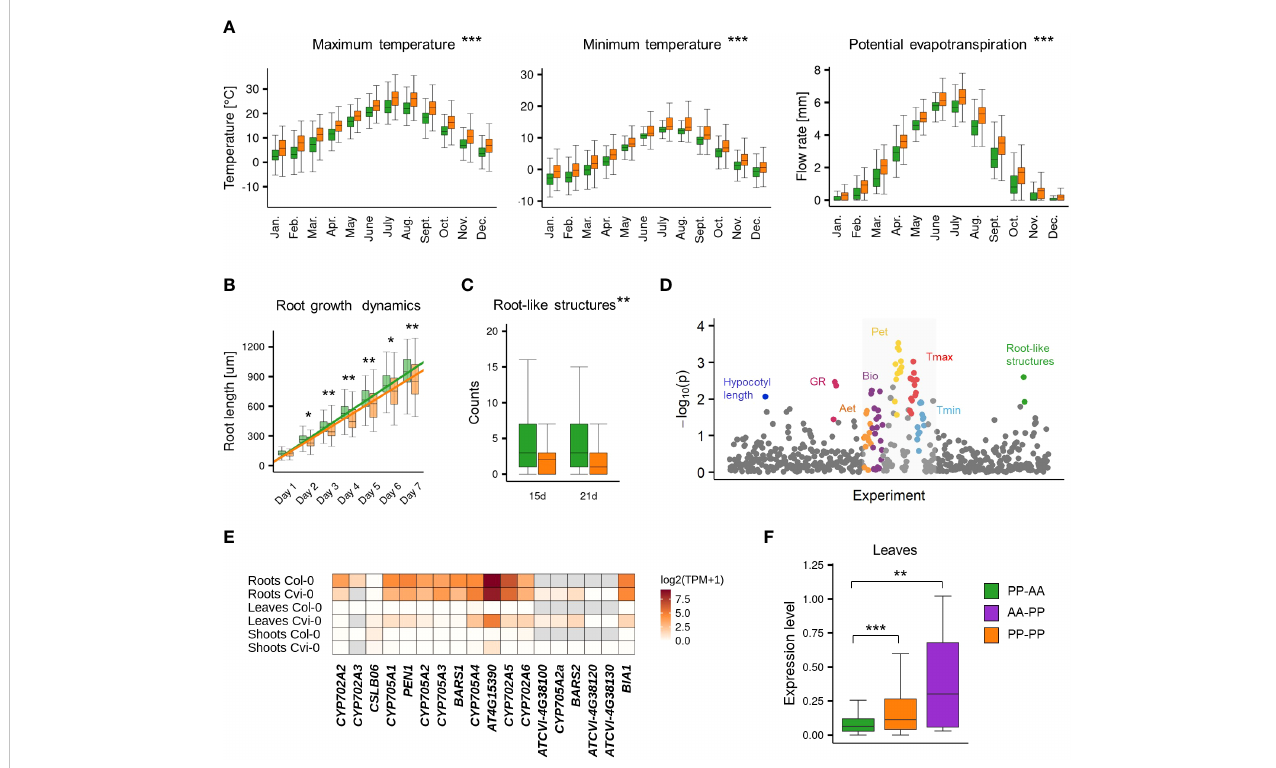
FIGURE 5 Phenotypic variation of PP-AA and PP-PP groups. (A-C) Two-group comparisons of climatic (A) , root growth dynamics (B) and root organogenesis (C) data between PP-AA (green) and PP-PP (orange) accessions. Stars denote the signi fi cance of Wilcoxon rank sum test with continuity correction, *p.value<0.1, **p.value<0.05, ***p.value<0.001. (D) Results of a genome-wide association study for PP-AA/PP-PP allelic variation. Study with climatic data is in the grey box (E) Tissue speci fi city of arabidiol/baruol gene cluster expression in Col-0 and Cvi-0. (F) Population-level differences in